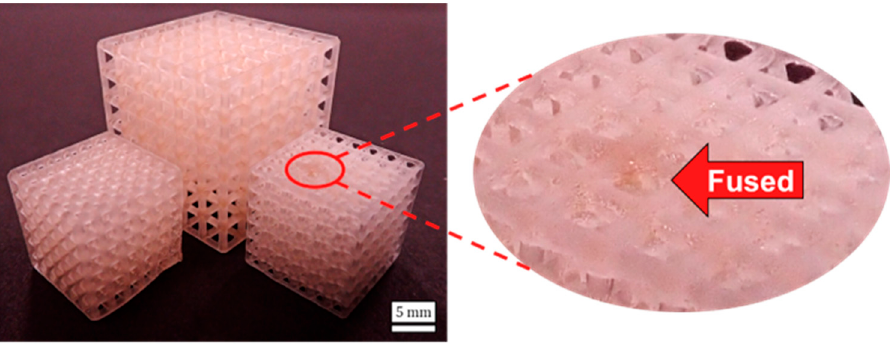
Figure 6. Fabricated lattices for Cube-800ø, BCC-800ø, and BCC-500ø designs (from left to right ). Circled zoomed region indicates fused pores.